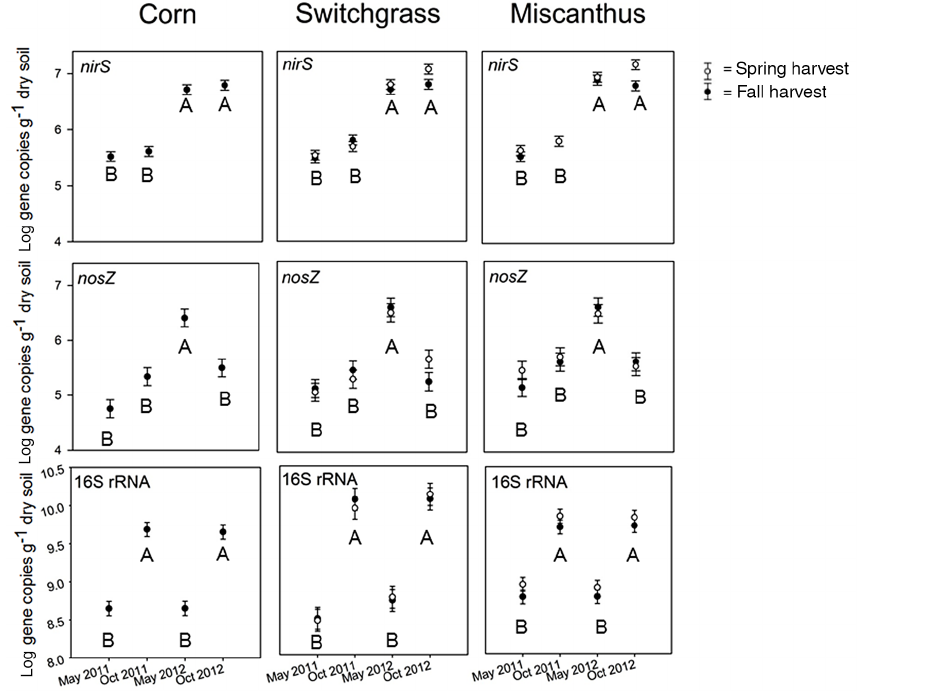
Figure 3. Mean log gene copies (g − 1 dry soil ± SE) in annual and perennial biomass cropping systems under varied harvest management at the Elora Research Station ( n = 6) over time. Different letters within panels indicate significant differences according to a post hoc Tukey’s test ( p <